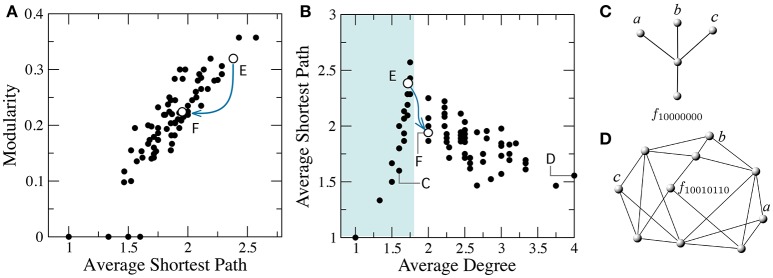
Breakdown of modularity involves a transition from tree-like to well-connected networks. (A) Correlation between average shortest path and modularity. (B) The average degree k* separates two main classes of minimal FFBNs: non-modular topologies with 〈k〉 > k* and tree-like networks with 〈k〉 ≤ k* ≈ 1.75 (cyan area). The minimal FFBNs for the functions f10000000
(C) and f10010110
(D) and the location of the multiplexer (F) and its ancestor function (E) are also shown. Blue lines denote the edge (f10101100, f10101110) in the phenotype network, which corresponds to a decrease in modularity and average shortest path.